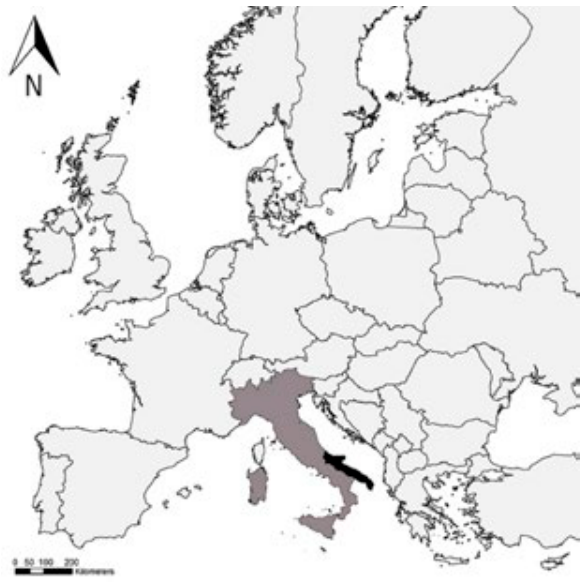
Figure 1. Study areas considered to model the potential distribution of Xylella fastidiosa in Italy: Apulia (training region, black) and the rest of Italy (projection area, black + dark